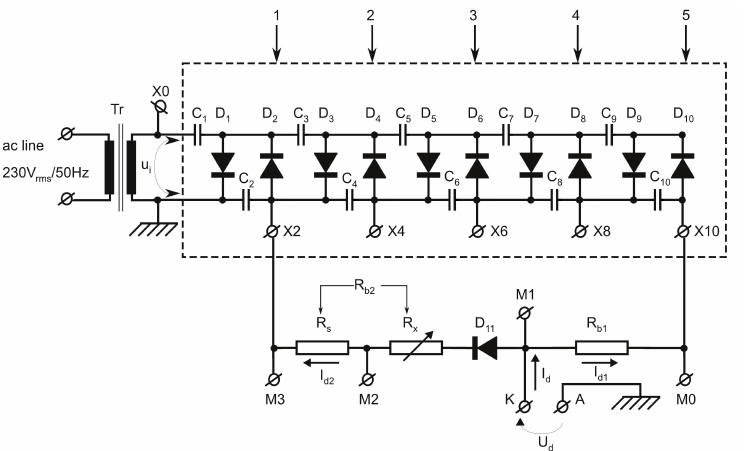
Figure 2. Diagram of the electrical supply circuit. The voltage multiplier, delimited by dashed rectangle, consists of ten identical 1 µ F capacitors C 1 –C 10 , and ten diodes D 1 –D 10 . All multiplier diodes D 1 –D 10 and additional diode D 11 are identical, BY6-type. The nominal values of the resistors are R b 1 = 10 M Ω and R s = 10 k Ω . Resistance R b 2 = R s + R x , where R x may have different values, being used to adjust discharge current. Transformer Tr ensures galvanic isolation between the ac power line and plasma source electrodes. Four voltage dividers are connected to points M0, M1, M2 and M3, to monitor some electrical parameters during plasma source